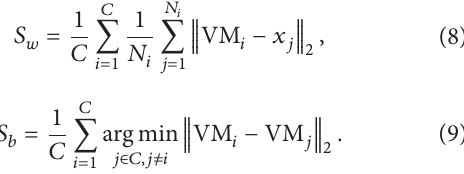
Table 2: Frequency domain statistical feature parameters.